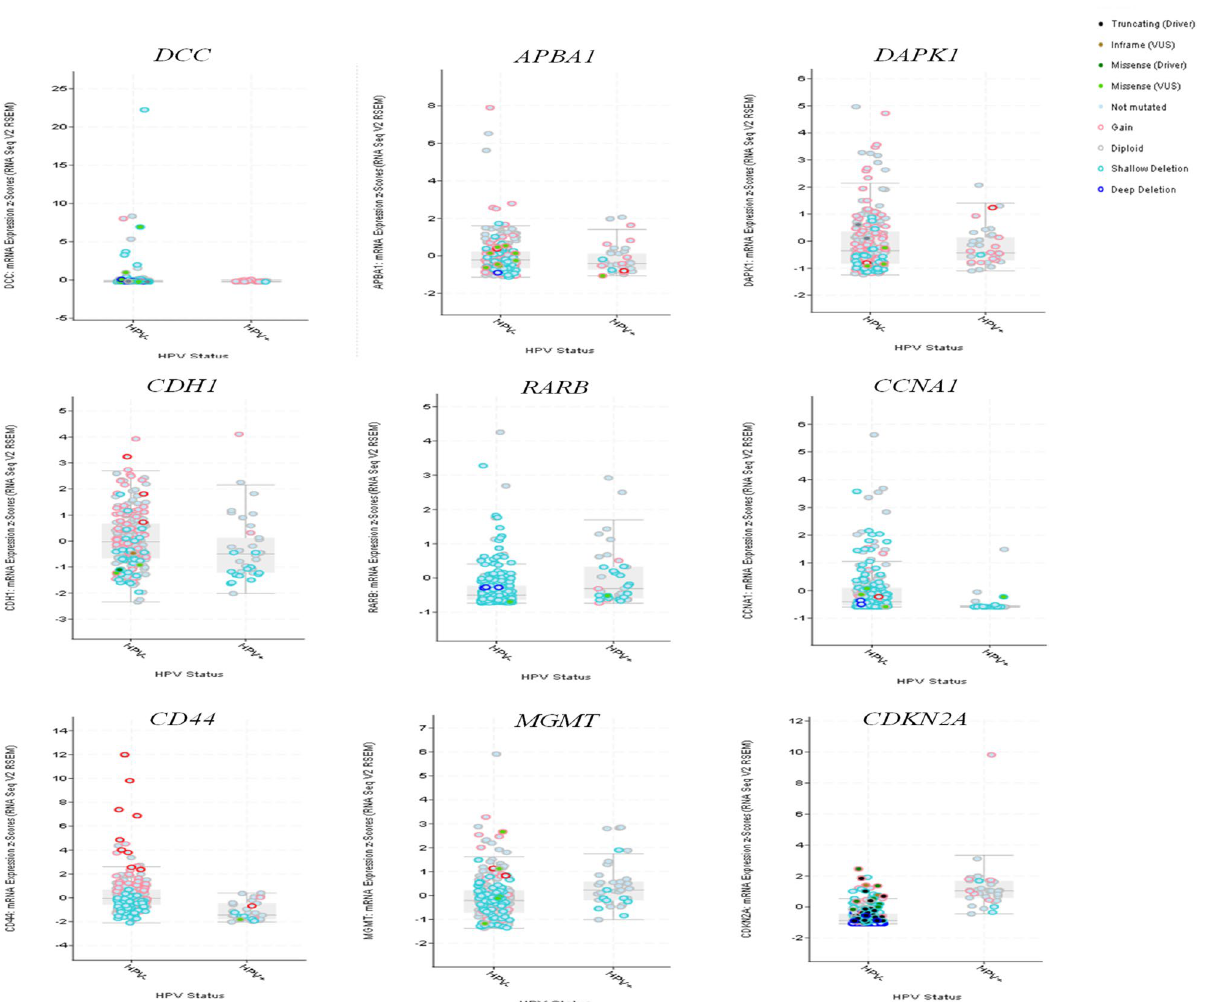
Figure 3. Validation of the gene expression in a large cohort of 279 HNC cases from Cancer Genome Atlas containing HM450 methylation, RNAseq data as well as information regarding alcohol, tobacco, and HPV infection. CD44 , CCNA1 , DCC and TIMP3 were hypermethylated in the HNC HPV-negative cases. Image done using the open-access resource for interactive exploration of multidimensional cancer genomics data sets cBio Cancer Genomics Portal (http:// cbiop ortal.